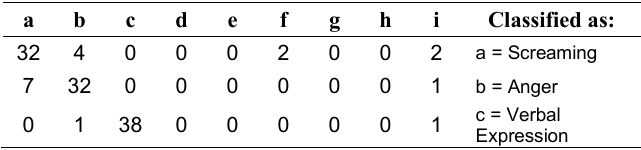
Table 2. Confusion matrix for the DNN on the 9 audio classes and 10-fold